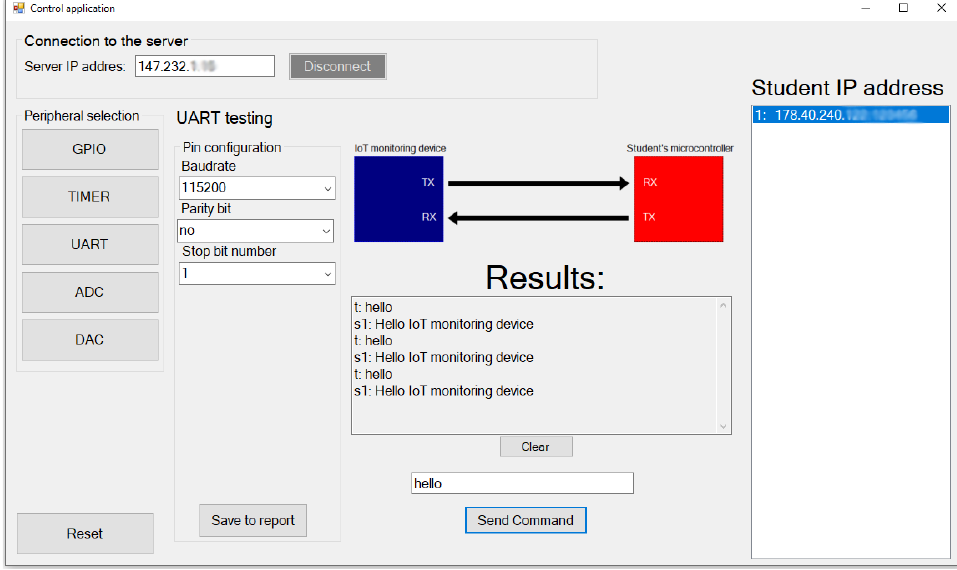
Figure 13. ADC peripheral testing.